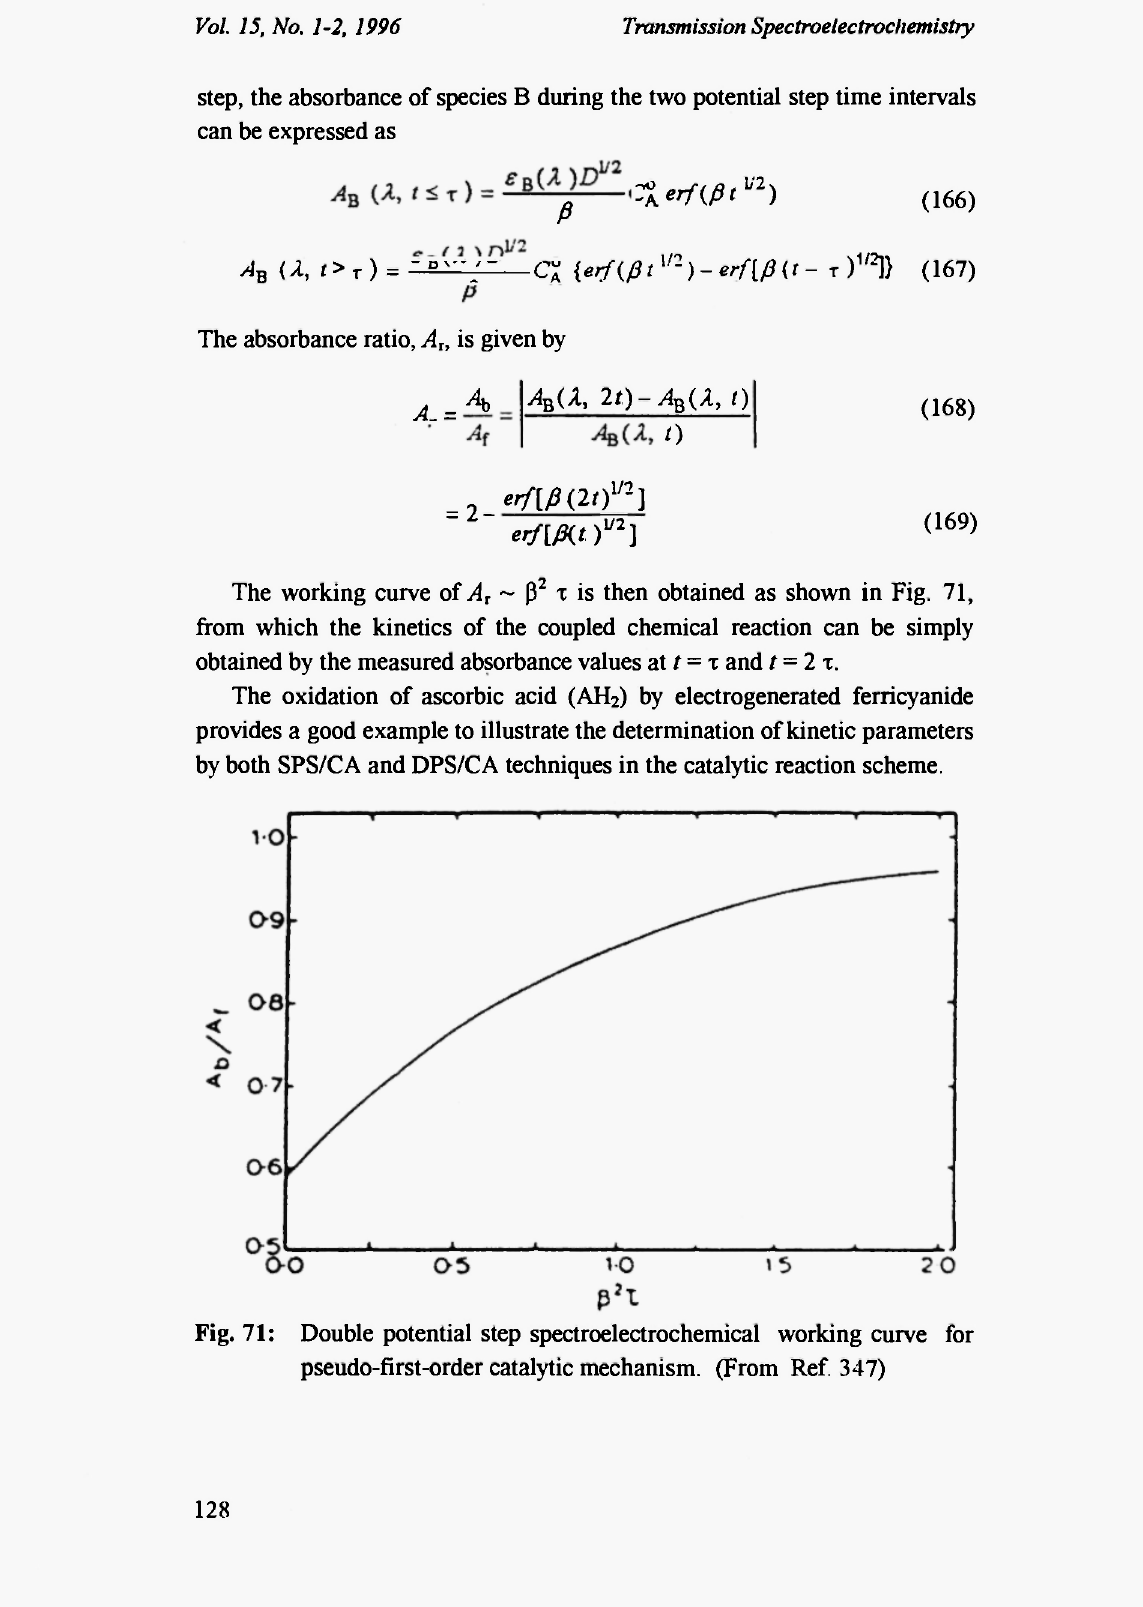
Fig. 71: Double potential step spectroelectrochemical working curve for pseudo-first-order catalytic mechanism. (From Ref.